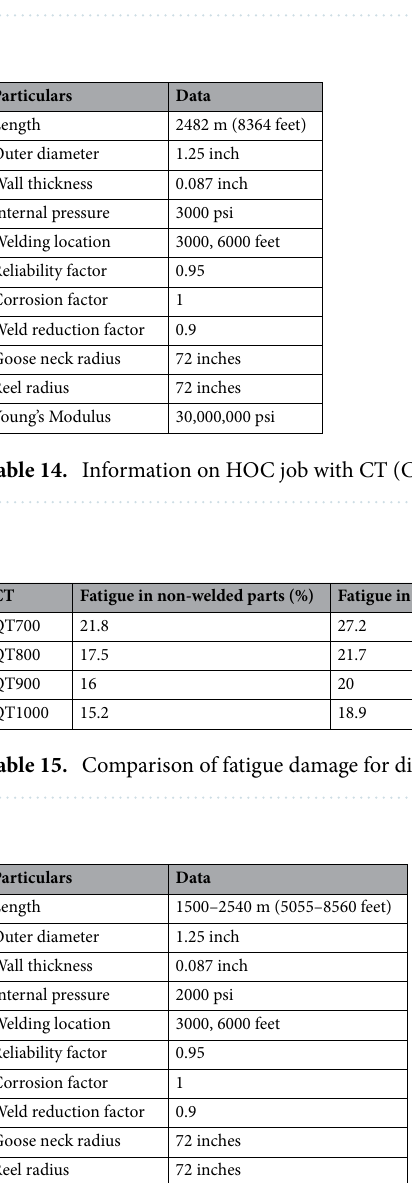
Table 13. Comparison of fatigue damage for various CTs.